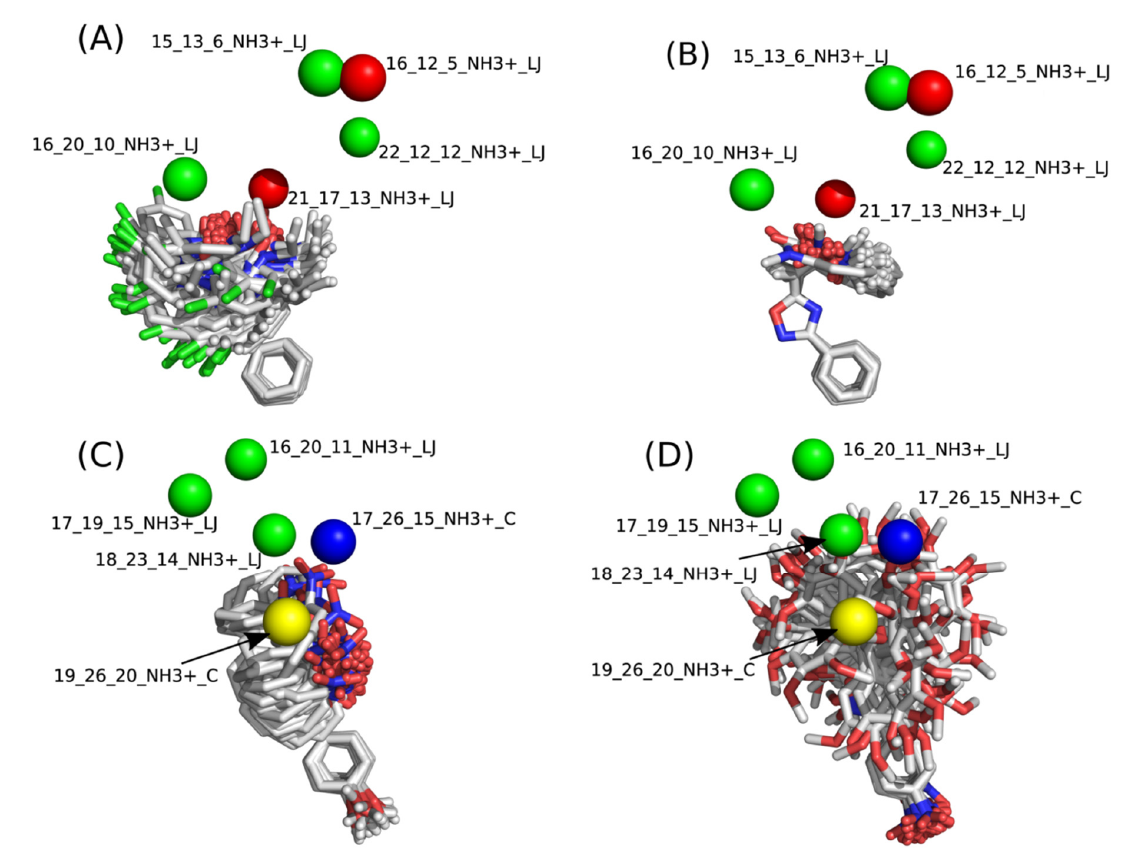
Figure 6. Contribution maps of the most and least potent compounds of group G 1 ( A , B ) and group G 2 ( C , D ).